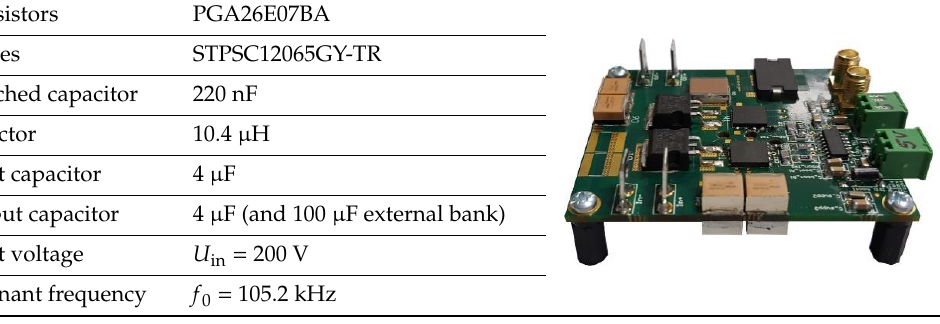
Table 3. Parameters of the laboratory SCVD converter.